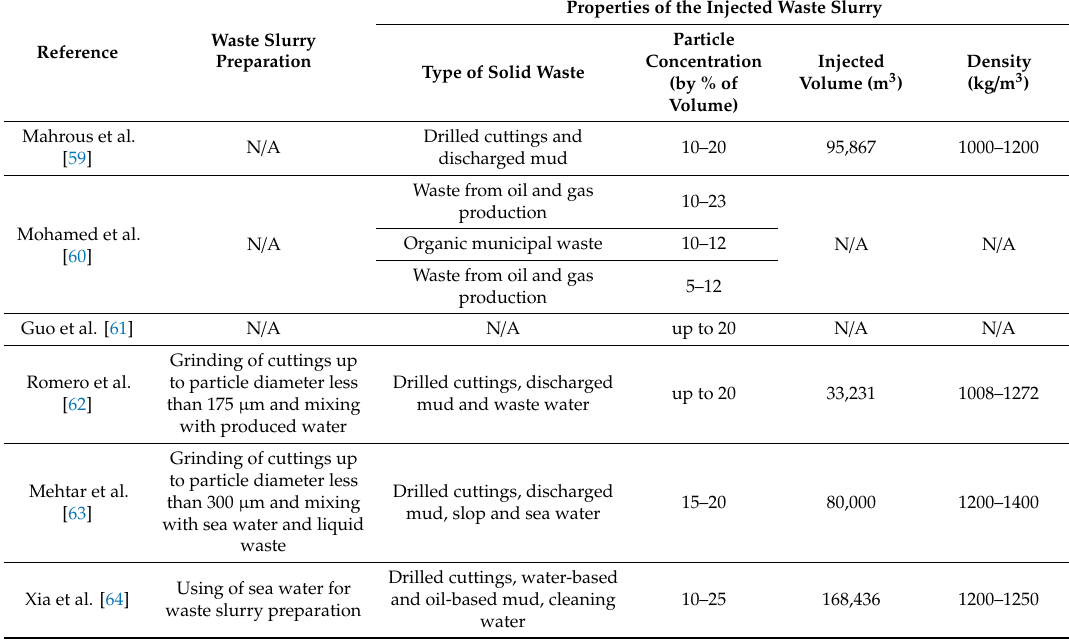
Table 3. Properties of injected waste slurry used in di ff erent injection